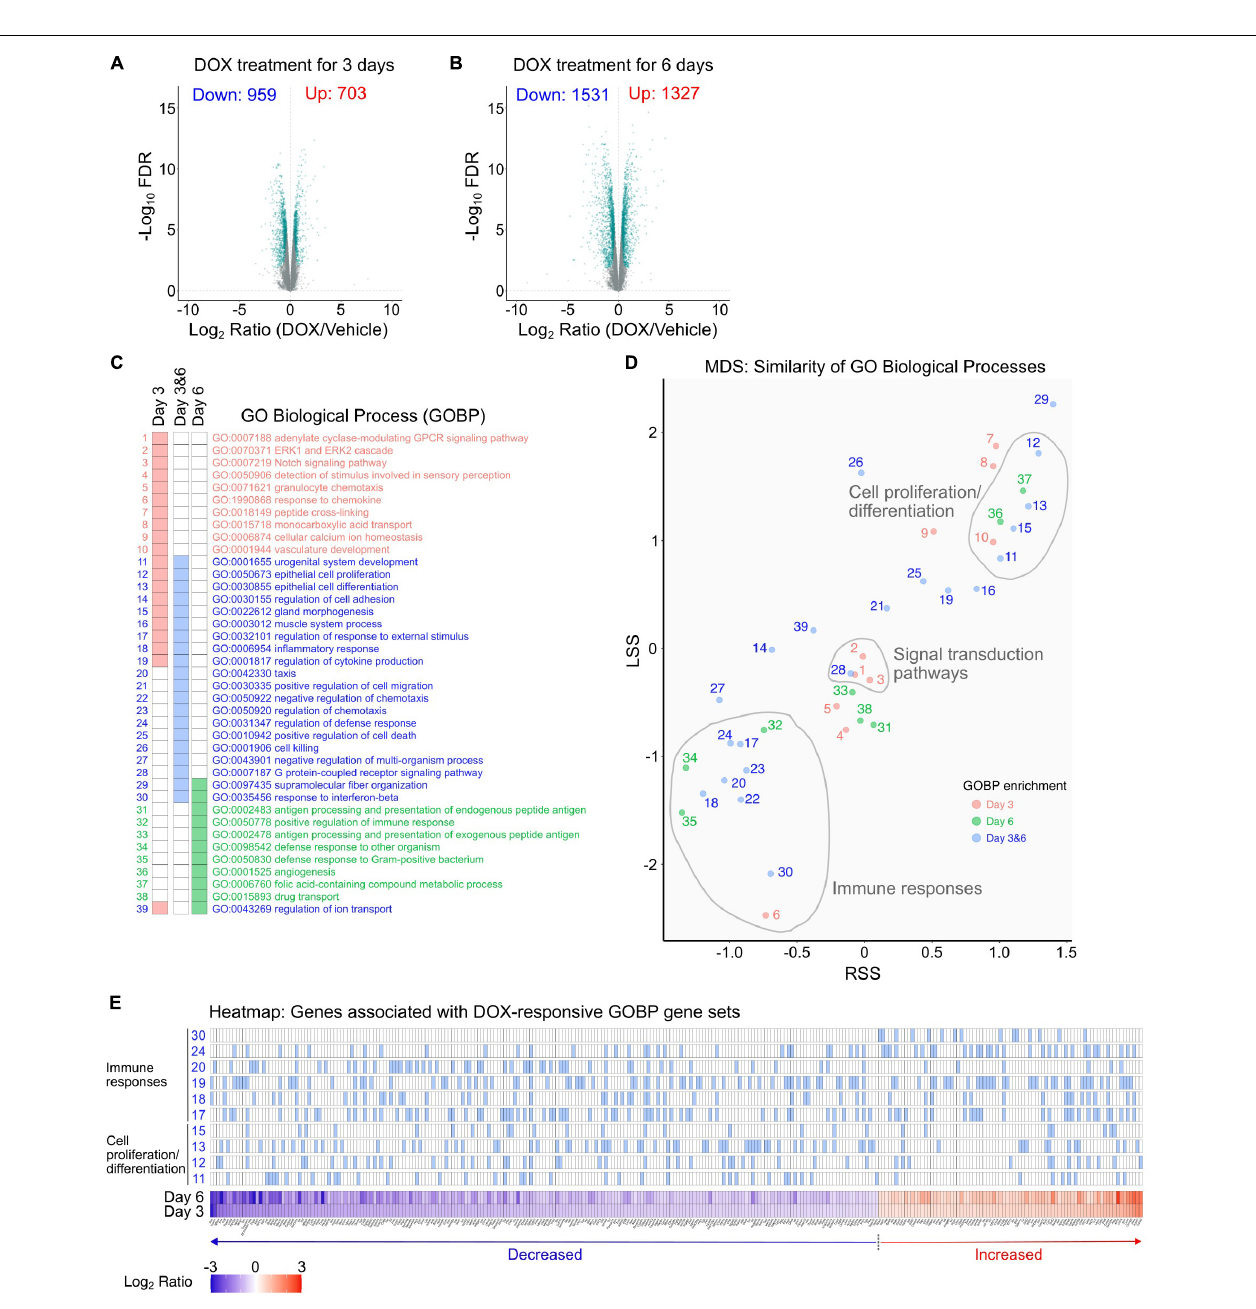
FIGURE 2 | DOX-responsive transcriptomic changes in mIMCD3 cells. (A,B) Identification of transcriptomic changes in mIMCD3 cells treated with DOX for 3 and 6 days using RNA-Seq-based differential expression analysis. Significantly changed genes (FDR < 0.05 over 20% expression change threshold) were labeled as green in volcano plots and used further downstream analysis. (C) Gene Ontology (GO) biological processes significantly enriched by DOX-responsive genes. Cellular processes (GO Biological Process) were identified from significantly changed genes by DOX treatment for 3 and 6 days. To avoid sample-source bias, whole transcriptome was used as a background gene set. Significant enrichment was considered as q < 0.05. (D) Bubble chart view of the GO term association using NaviGO . In the plot, the X -axis is the Resnik semantic similarity score (RSS) and the Y -axis chosen is Lin’s similarity score (LSS). GO terms are colored according to time point when DE genes are found, day 3, pink; day 6: green; and day 3 and 6: blue. The number of GO terms are listed in (C) . (E) Heatmap of gene sets associated with “cell proliferation/differentiation” and “immune responses.” Full list of genes associated with GO terms are provided in Supplementary Table 4